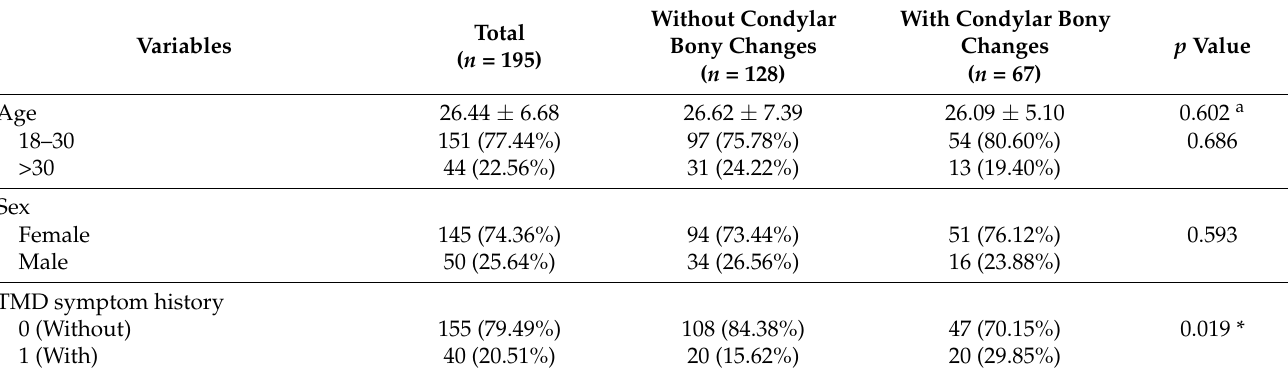
Table 4. Baseline characteristics of the participants and subgroup